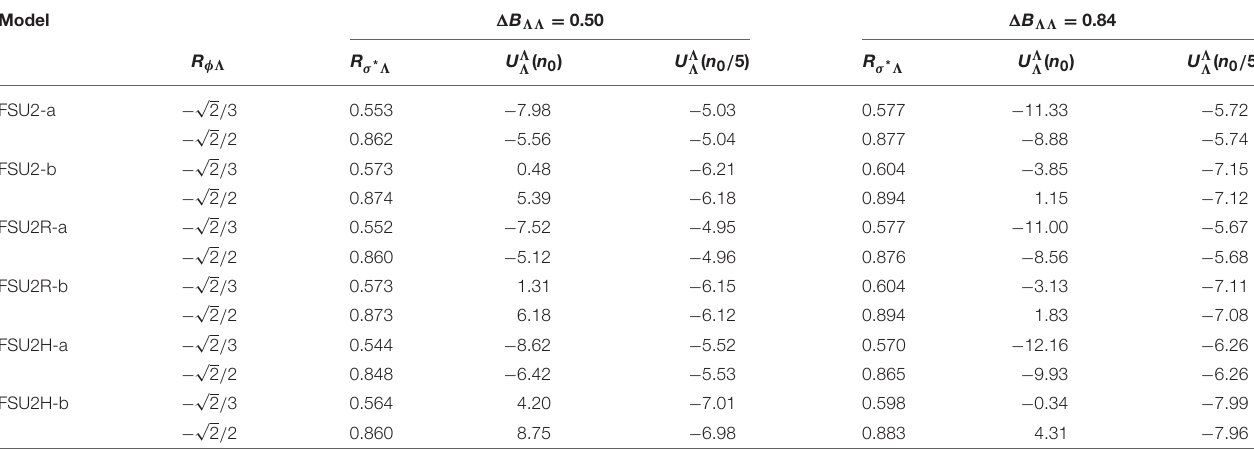
TABLE 4 | Calibration to double 3 -hypernuclei for models -a and -b of Table 3 . Model